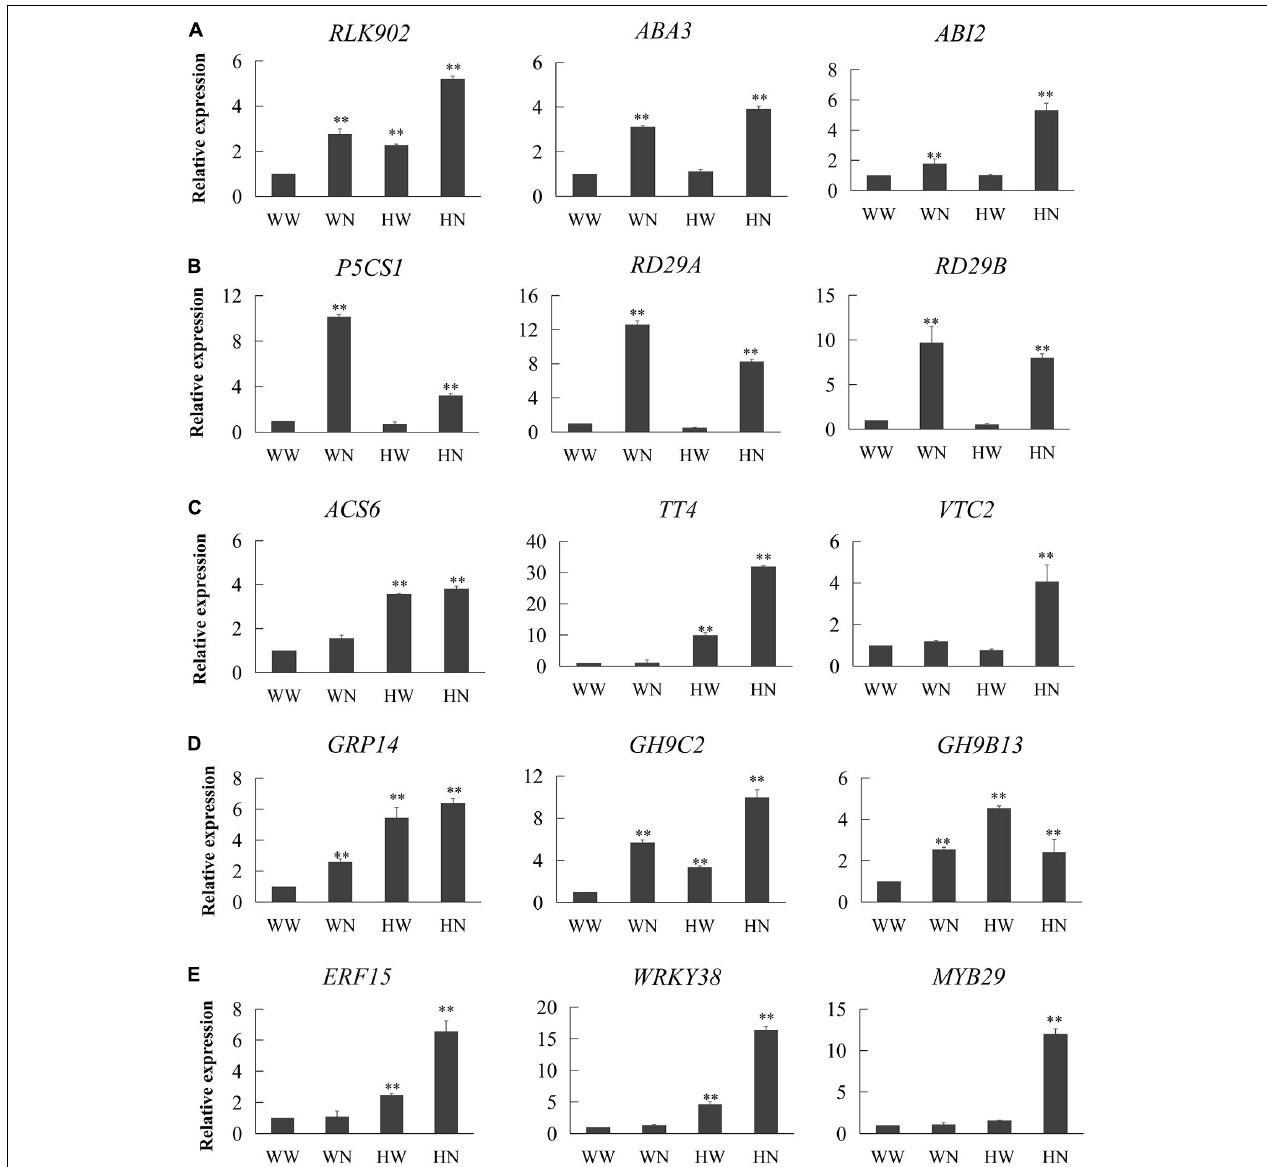
FIGURE 5 | Confirmation of transcriptional changes by RT-qPCR. We selected 15 genes from the transcriptome to detect their expression trends: (A) genes involved in signal transduction, (B) genes involved in responding to osmotic stress, (C) genes involved in response to oxidation–reduction process, (D) genes involved in cell wall organization, and (E) genes related to transcription factors. The expression trends of these genes in the transcriptome are given in Tables 1 , 2 . RT-qPCR results are presented in the form of 2 − (cid:77)(cid:77) CT . Three biological replicates per experiment. Data are represented as means ± SD. * and ** represented significantly and very significantly different at P < 0.05 and P < 0.01, respectively, estimated with one-way ANOVA following SPSS. WW, pretreated with water and not salt-stressed; WN, pretreated with water and salt-stressed; HW, pretreated with H 2 O 2 and not salt-stressed; HN, pretreated with H 2 O 2 and